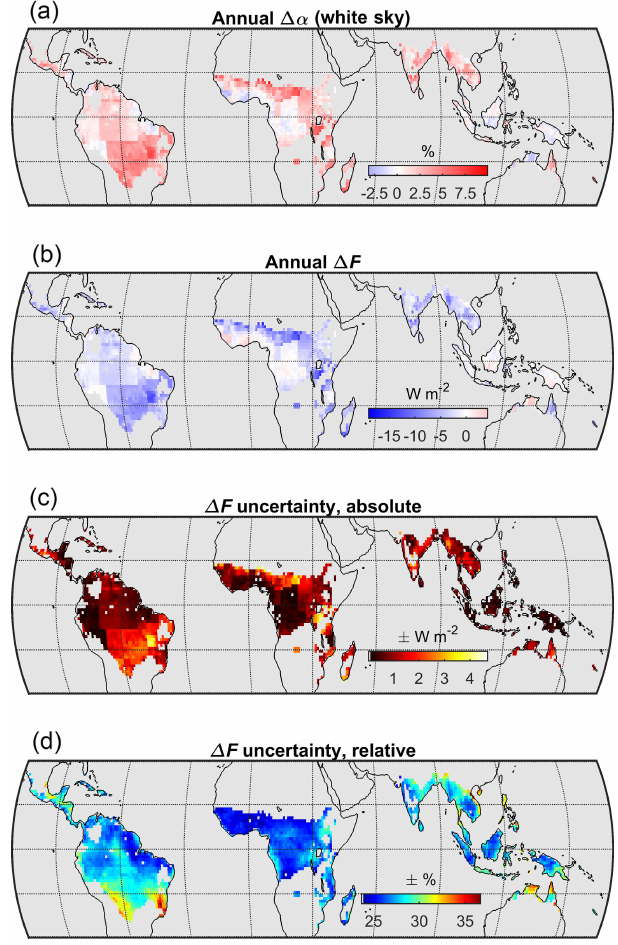
Figure 6. Example application of a CACK based on the 2001–2016 monthly mean CERES EBAF v4 climatology to estimate the lo- cal annual mean (cid:49)F from a hypothetical land cover change within a CERES grid cell. (a) Annual mean of the climatological (i.e., 2001–2011) monthly mean difference in white-sky surface albedo between croplands and evergreen broadleaved forests ( (cid:49)α s ) based on the 1 ◦ product of Gao et al. (2014); (b) annual mean local (i.e., within grid cell) instantaneous radiative forcing ( (cid:49)F ) of monthly mean (cid:49)α s estimated with CACK; (c) absolute uncertainty (annual mean) of the CACK-based (cid:49)F estimate, including the uncertainty of (cid:49)α s ; (d) relative uncertainty (annual mean) of the CACK-based (cid:49)F